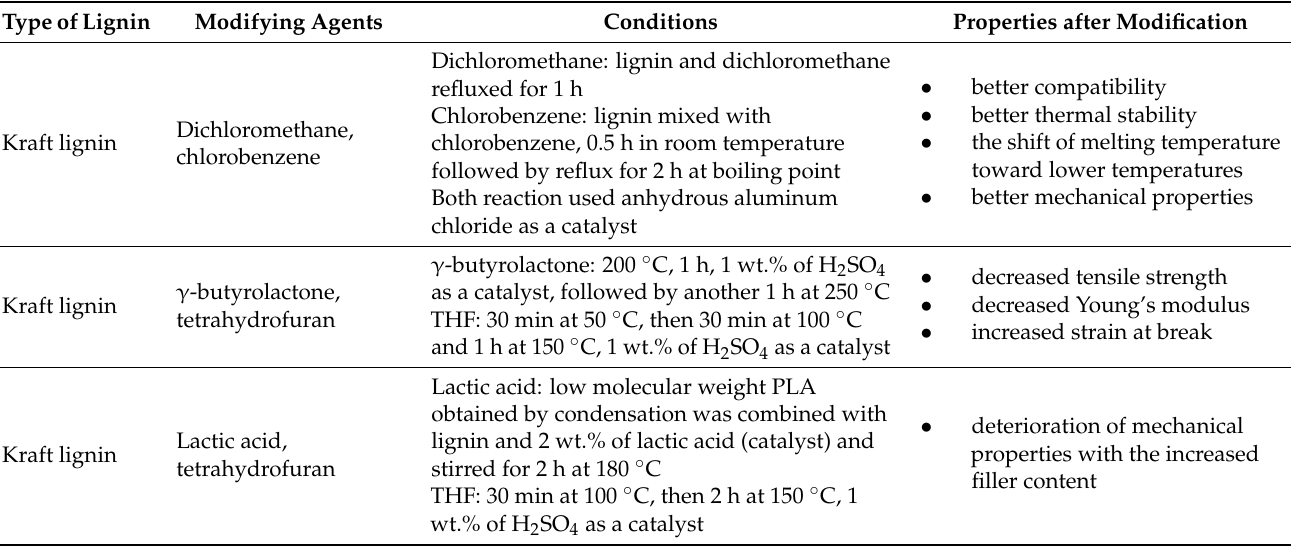
Table 6. Table summarizing alkylation and arylation processes of